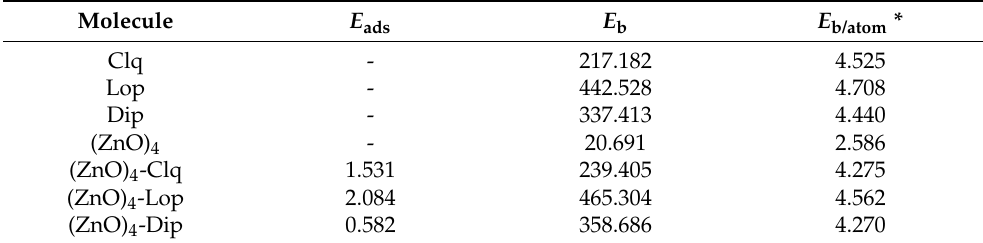
Table 1. Energy of adsorption, binding energy, and binding energy per atom (in eV), for the studied molecules, using M06L/6 ‐ 31G(d,p).